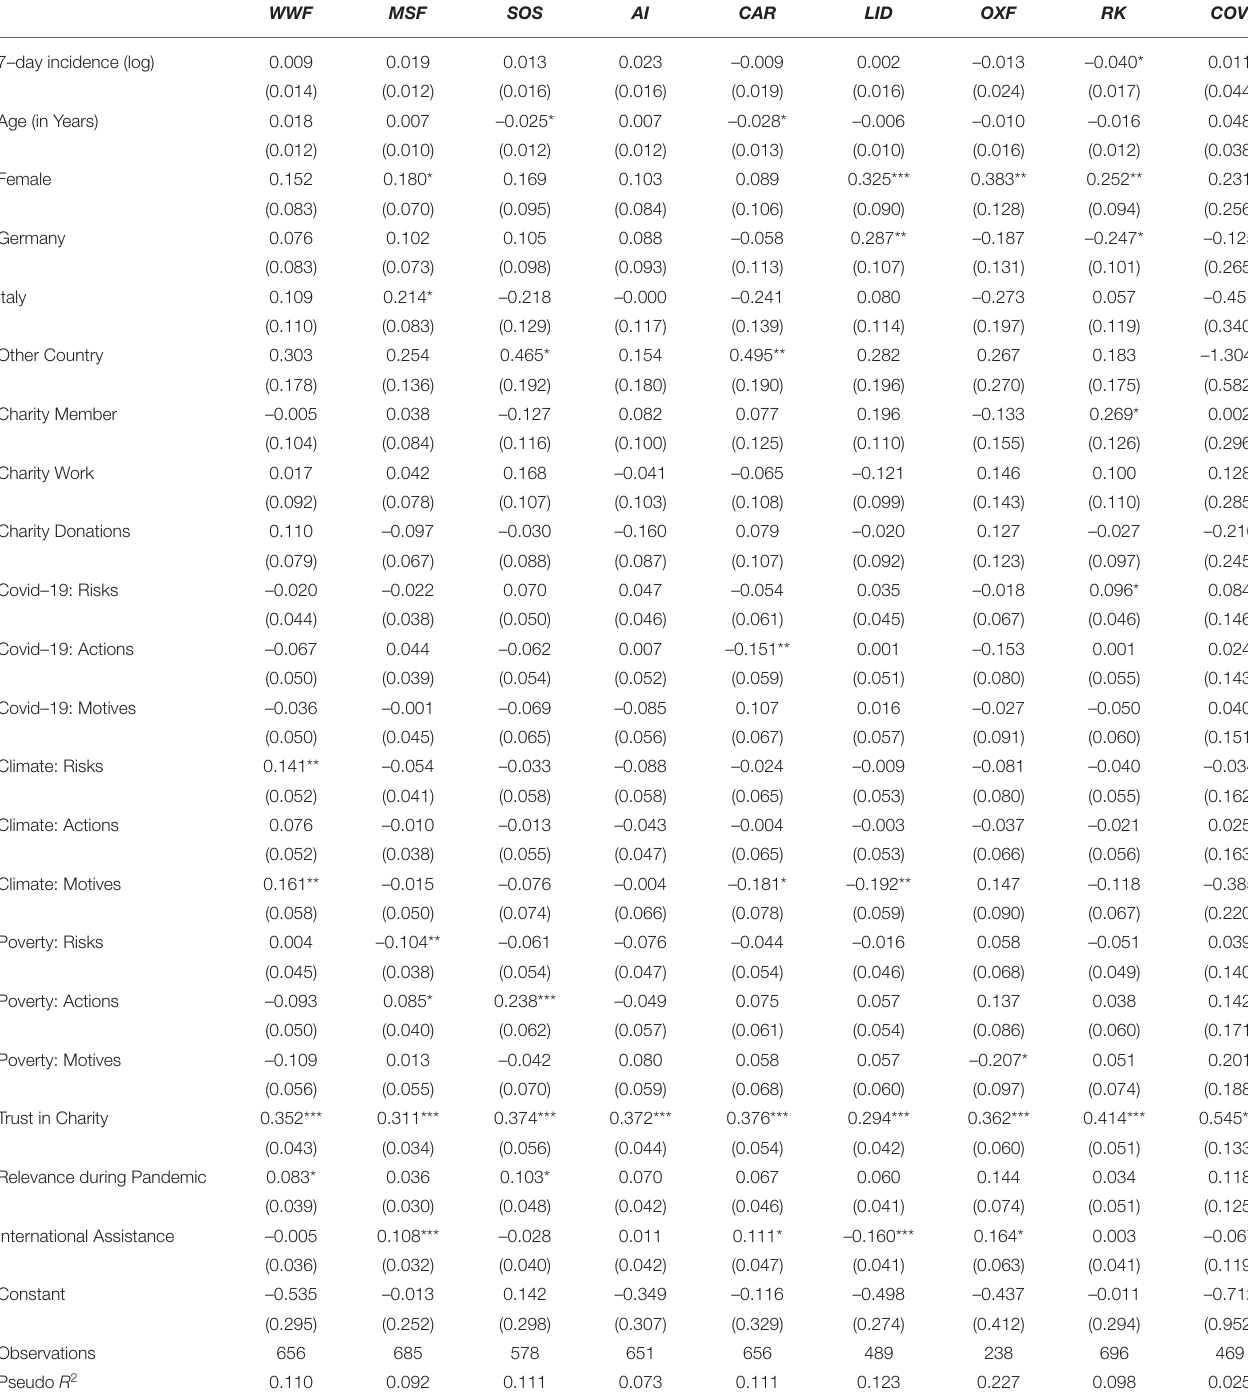
TABLE 3 | Regression analyses of donations to charity (pooled across all treatments) on 7-day incidence rates and individual-level characteristics, separated by the eight charities and the WHO Covid-19 Fund . WWF MSF SOS AI